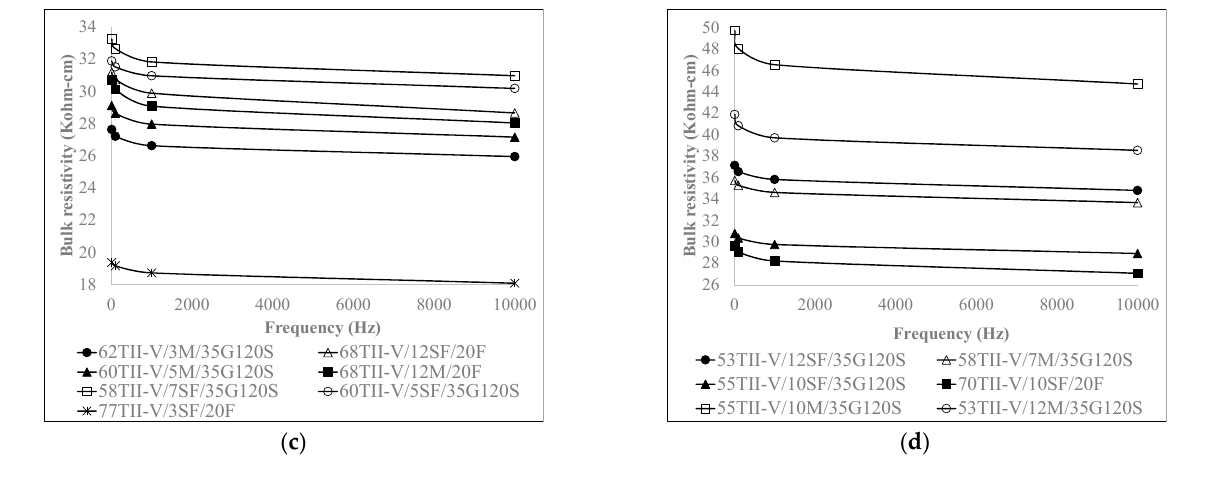
Figure 3. Influence of frequency on BR at 28 days on ( a ) control and binary mixtures, and ( b – d ) ternary mixtures.